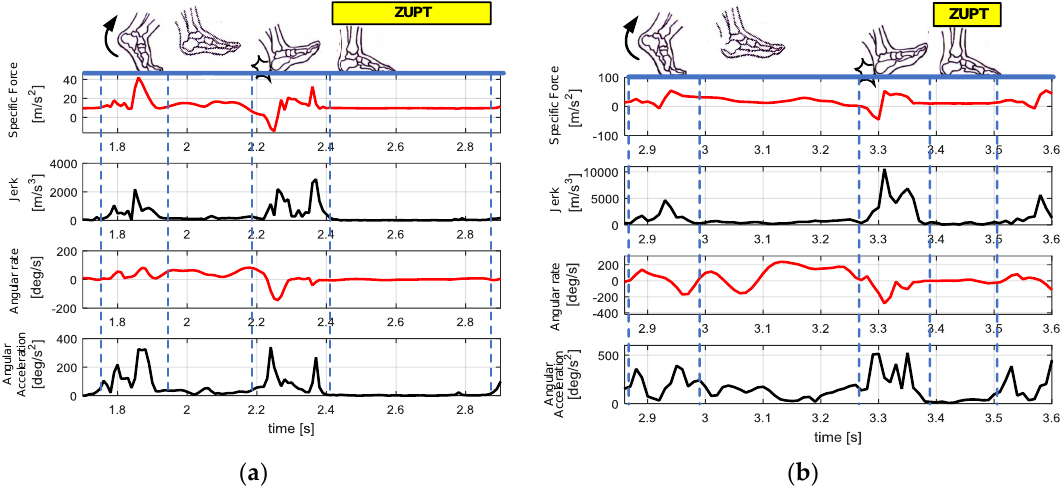
Figure 3. Variations of the foot motion parameters during one gait cycle in different states. ( a ) Walking; ( b ) jogging.